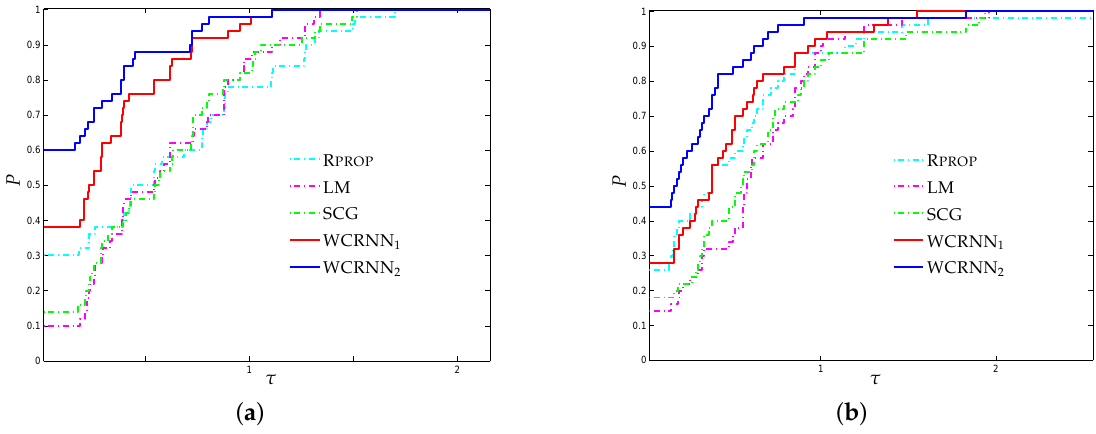
Figure 3. Log 10 scaled performance profiles for the banknote authentication classification problem. Figure 2. Log 10 scaled performance profiles for the German credit approval classification problem.